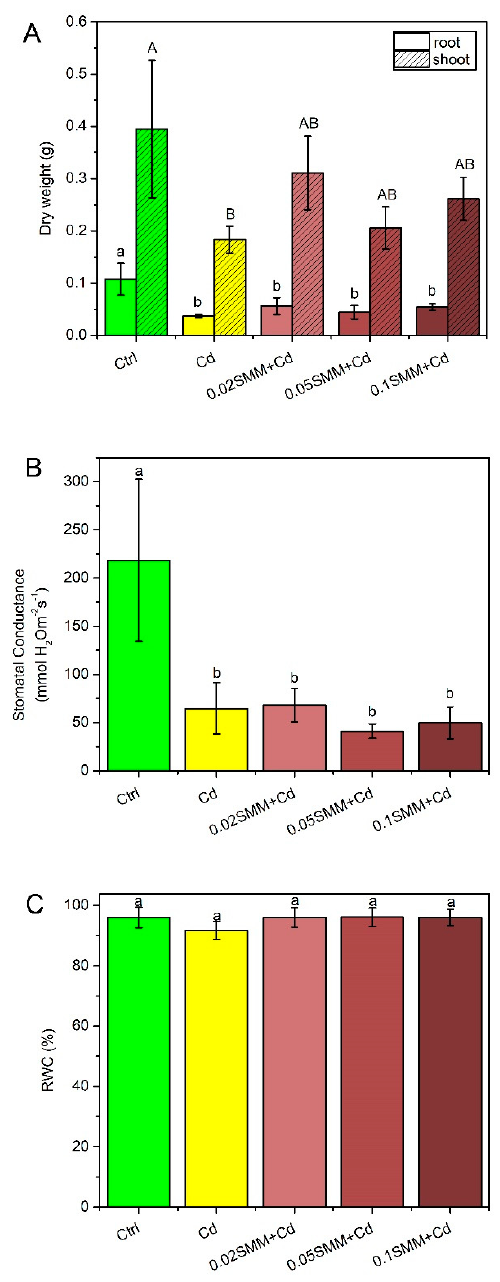
Figure 1. Root and shoot dry weight ( A ), stomatal conductance ( B ) and RWC ( C ) of the youngest fully developed leaves of Szarvasi-1 energy grass primed with 0.02, 0.05 and 0.1 mM SMM and exposed to 0.01 mM Cd. Error bars represent SD values. To compare the differences, one-way ANOVA was performed on each dataset combined with Tukey–Kramer post hoc test on the treatments ( p < 0.05). Different lowercase and uppercase letters indicate significantly different groups. The total Chl concentration of the youngest fully developed energy grass leaves was reduced significantly in the plants exposed to Cd stress, as compared to the Ctrl (Figure